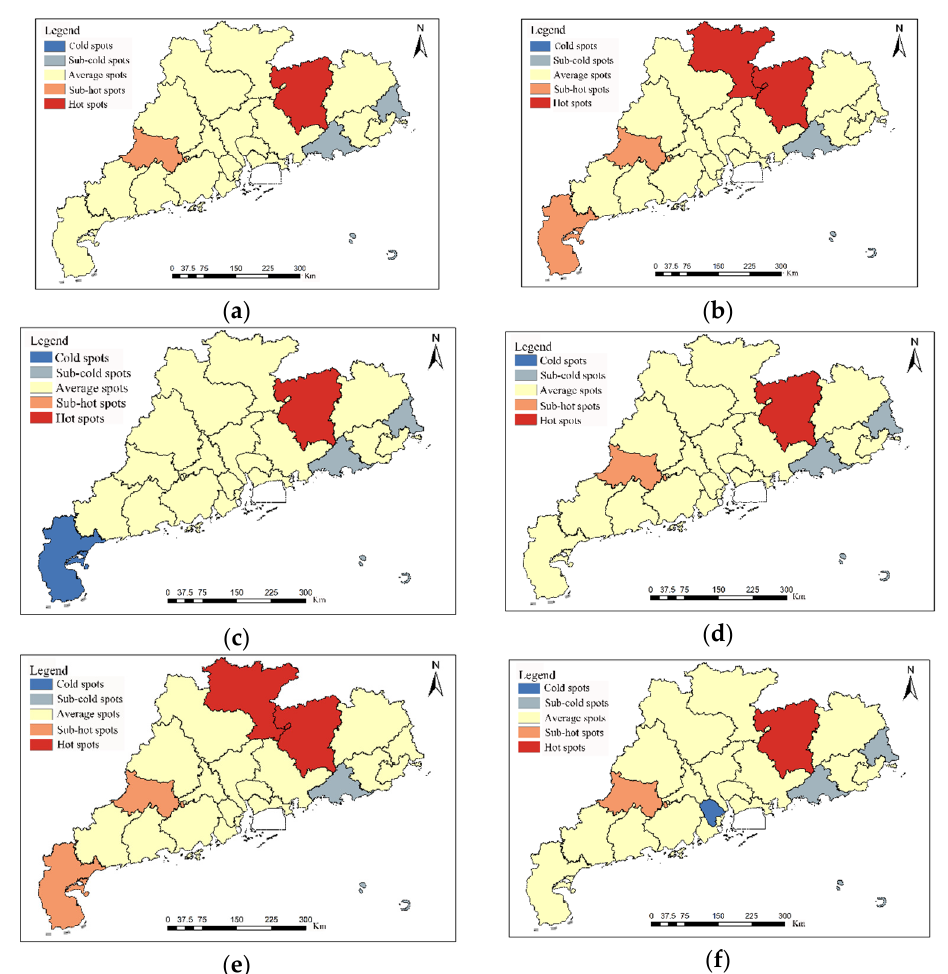
Figure 3. Hot spot maps of the spatial distributions of rural tourism resources in Guangdong. ( a ) Total rural tourism resources. ( b ) Rural industry integration. ( c ) Rural settlement architecture. ( d ) Rural historic sites. ( e ) Rural folk culture. ( f ) Rural nature